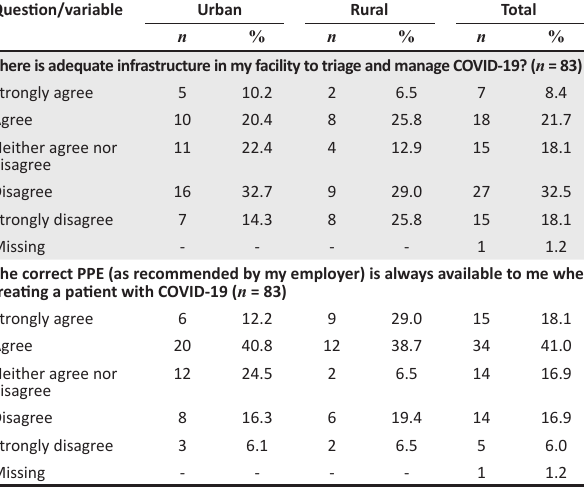
TABLE 2: Infrastructure and equipment organisation.